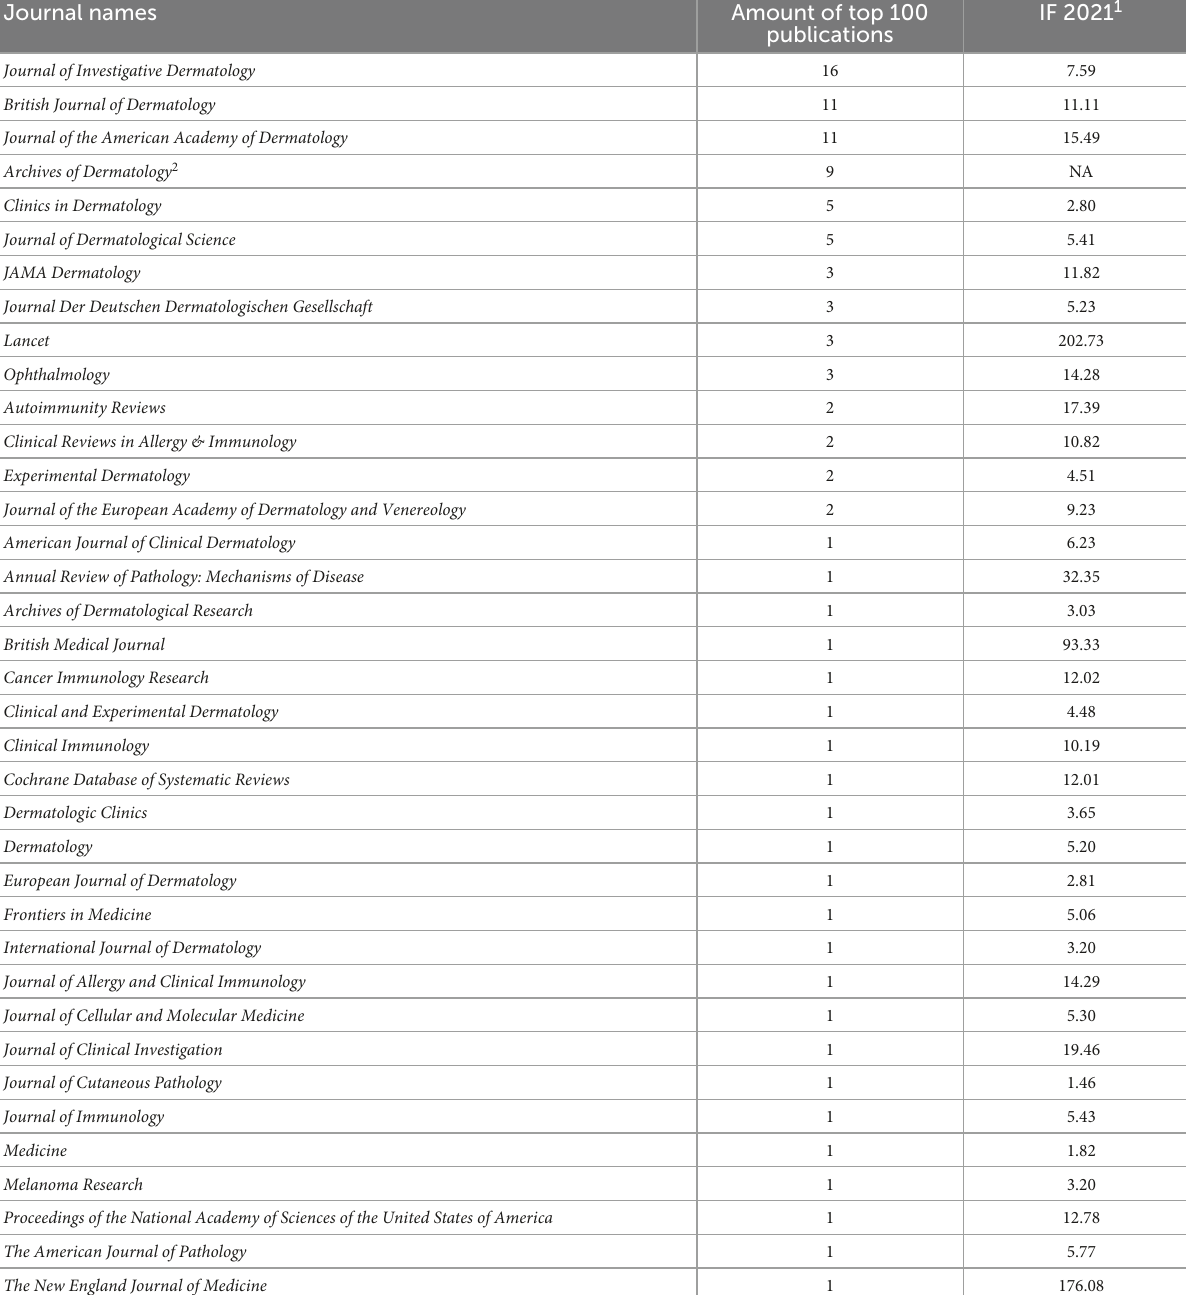
TABLE 1 Journal information for the top 100 most-cited publications of pemphigoid